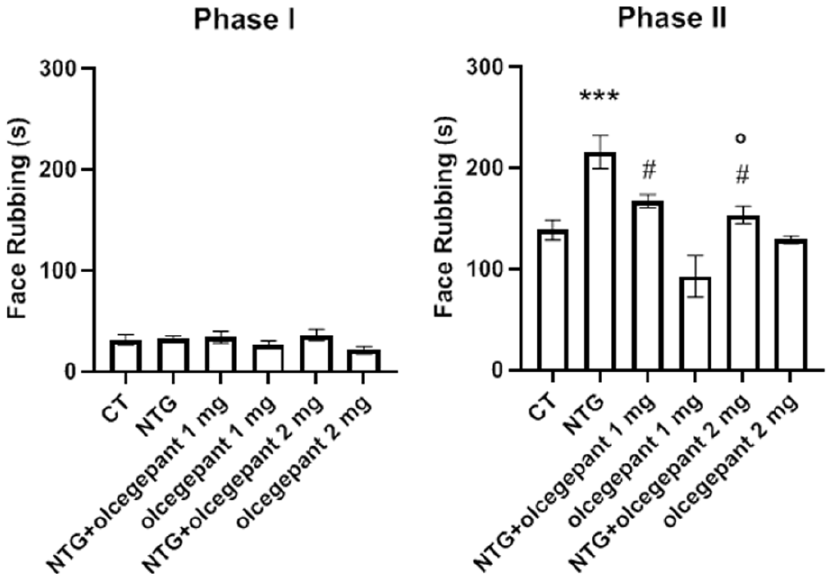
Figure 2. Time of face rubbing (expressed in seconds) during Phase I and II of the orofacial formalin test following acute systemic adminsitration of nitroglycerin (NTG)/vehicle and olcegepant/vehicle. Data are expressed as mean ± SEM. One-way ANOVA followed by Tukey’s multiple comparisons test: *** p < 0.001 vs. control (CT), olcegepant 1 mg and olcegepant 2 mg; ° p < 0.05 vs. NTG; # p < 0.05 vs. olcegepant 1 mg.